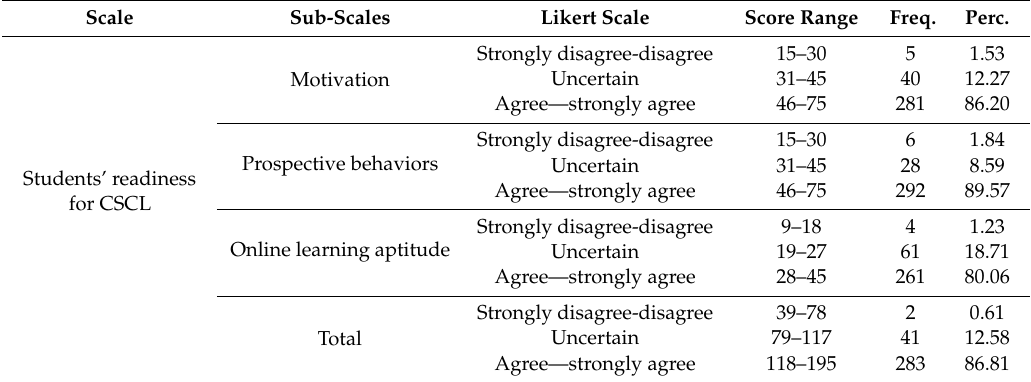
Table 4. Frequency and percentage of Likert scale